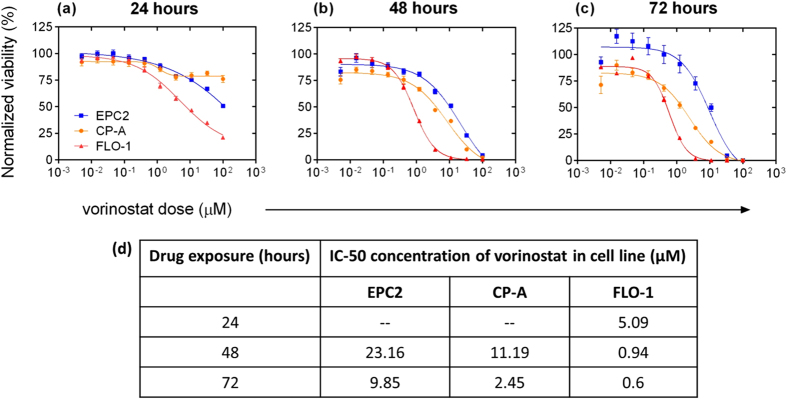
Vorinostat reduces viability of FLO-1 esophageal adenocarcinoma cells relative to metaplastic CP-A and normal squamous EPC2 cells.Drug-dose response (DDR) curves after: (a) 24, (b) 48 and (c) 72 hours of vorinostat exposure. (d) FLO-1 cells have a significantly lower IC-50 values compared to CP-A and EPC2. The missing IC50 values (depicted as --) for EPC2 and CP-A cells at the 24 hour time point in (d) indicate that these cells had minimal response to the drug at this time point. The resulting data (n = 6 for each dose) were analyzed by using the Dose-response-inhibition, variable slope function in Prism 6 (Graphpad Software, San Diego, CA) after normalization to growth of cells alone and with the vehicle control DMSO. Error bars represent the standard error of the mean (SEM).